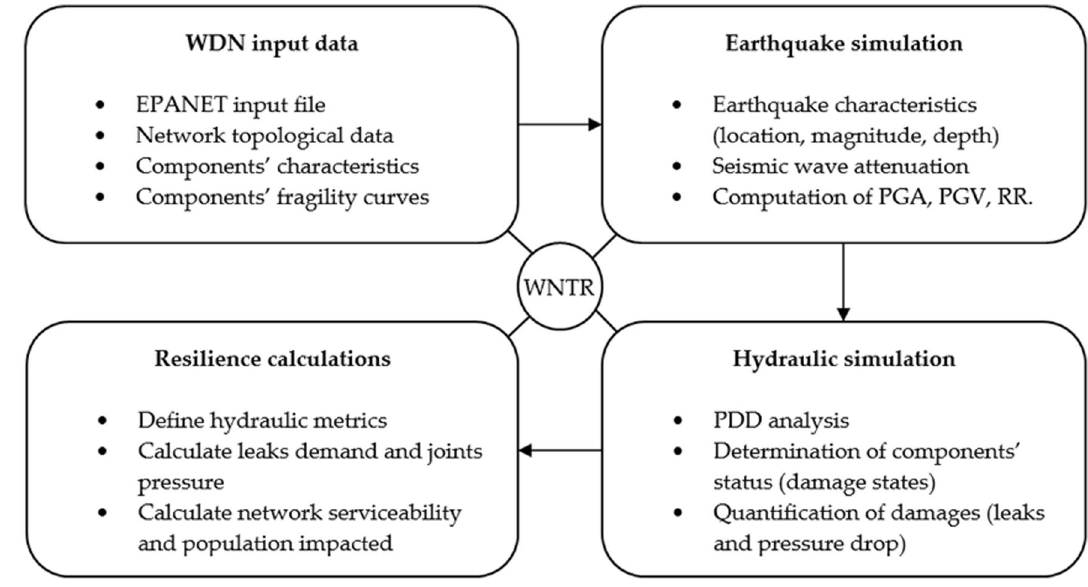
Figure 1. Flowchart of earthquake simulation in